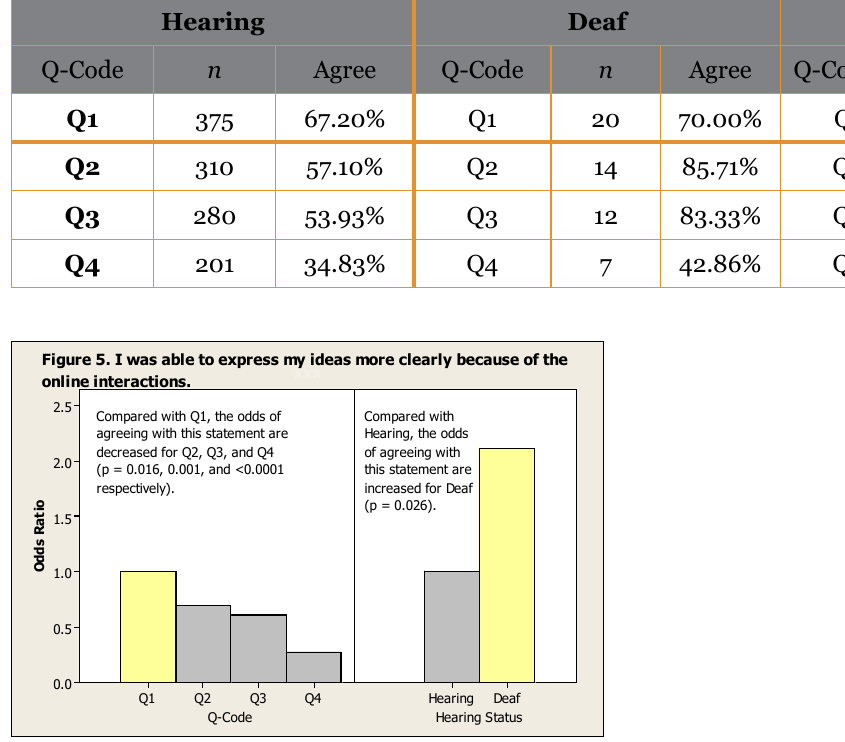
Figure 5 . Odds-Ratios for “I was able to express my ideas more clearly because of the online in-